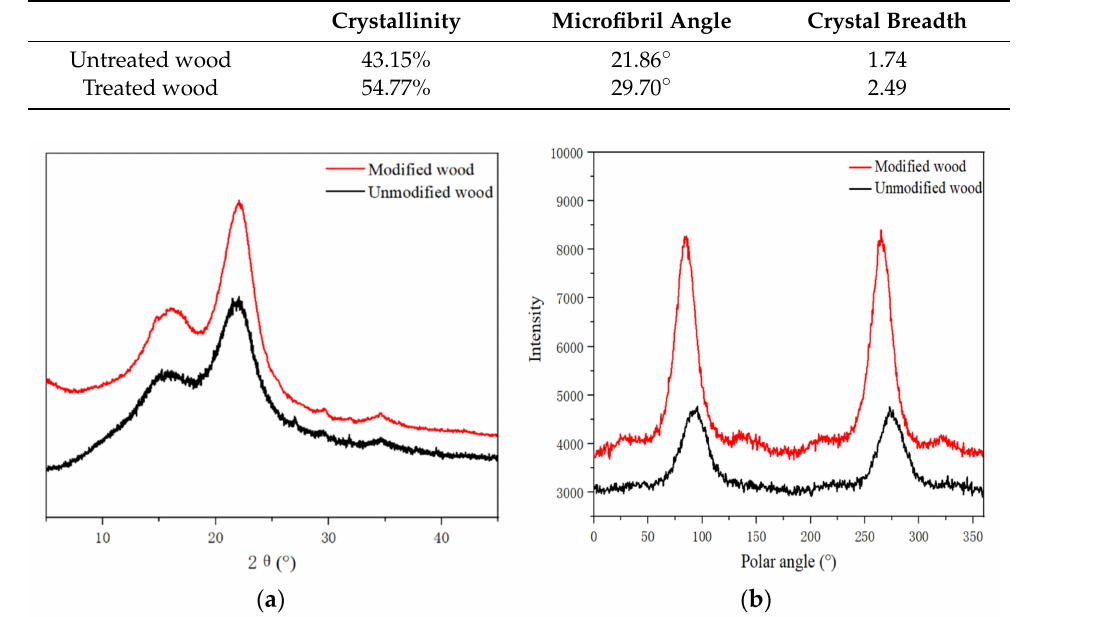
Table 3. Parameters of treatments for each wood sample.